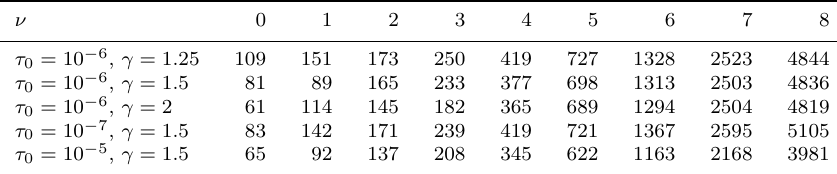
Table 1. The number of time steps N = N ( δ,τ 0 ,γ